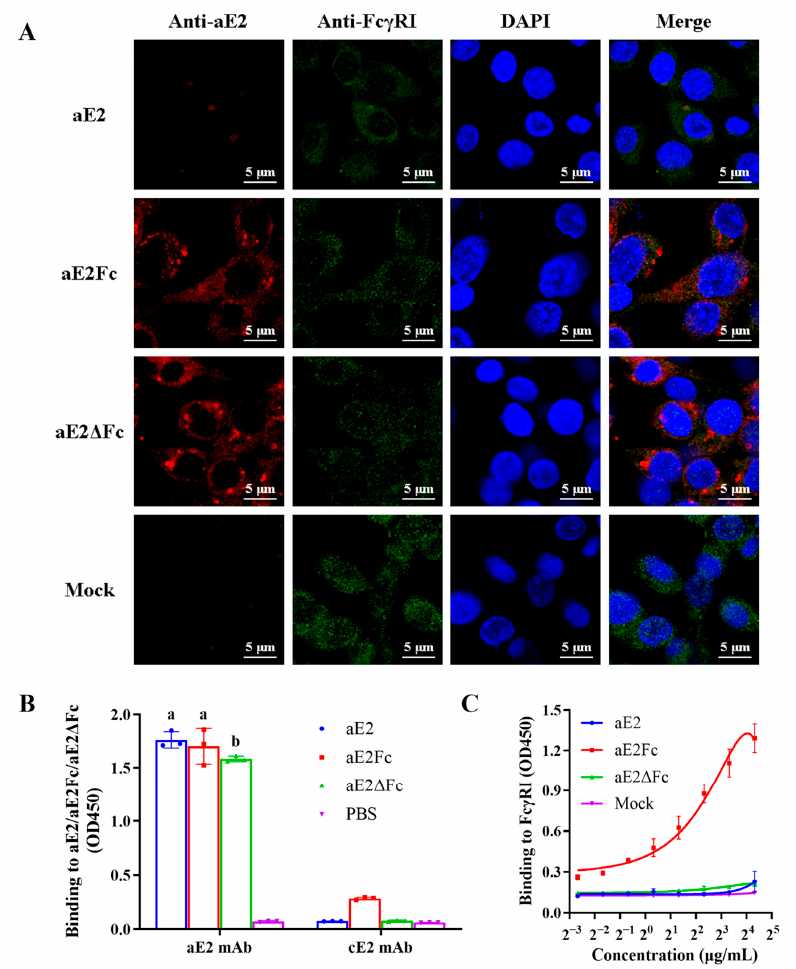
Figure 4. Functionality and antigenicity of APPV E2, E2Fc, or E2 Δ Fc fusion proteins. ( A ) Co-localization of Fc γ RI on macrophages and APPV E2Fc or E2 Δ Fc fusion protein. Immunofluorescent microscopic photomicrographs displayed localization of Fc γ RI on macrophages and the pAb Fc γ RI (CD64)-immunoreactive green fluorescence was detected by Alexa Fluor 488 goat anti-rabbit antibody. While the localization of E2 in Fc γ RI was analyzed through the mAb E2-immunoreactive red fluorescence using Alexa Fluor 555 goat anti-mouse antibody. The nuclei (blue) were labeled with DAPI. Binding affinity of APPV E2, E2Fc, and E2 Δ Fc fusion proteins to APPV-specific (aE2) mAb ( B ) and Fc γ RI ( C ). ELISA was performed to detect the binding affinity of APPV E2, E2Fc, and E2 Δ Fc fusion proteins to APPV-specific (aE2) mAb and Fc γ RI. Binding affinity was characterized as OD450 value. CSFV-specific (cE2) mAb was assessed to investigate the cross- reactivity. PBS was used as a negative control. Different letters (a, b) indicate a statistically significant difference between different experimental groups ( p < 0.05). Experiments were conducted independently in triplicates. Data are represented as the mean ± SD (n = 3).